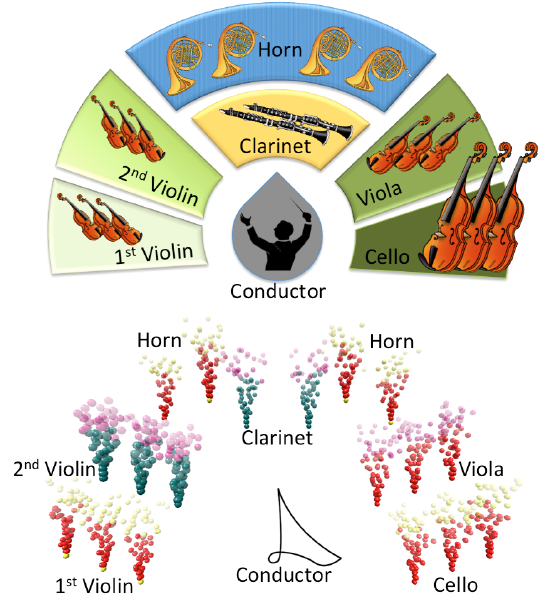
Fig. 4: Orchestral seating arrangement and distribution of section/instruments: string in shades of green (3 first Violins, 3 second Violins, 3 Violas, and 3 Cellos), brass in yellow (4 Horns), and woods in orange (2 Clarinets).